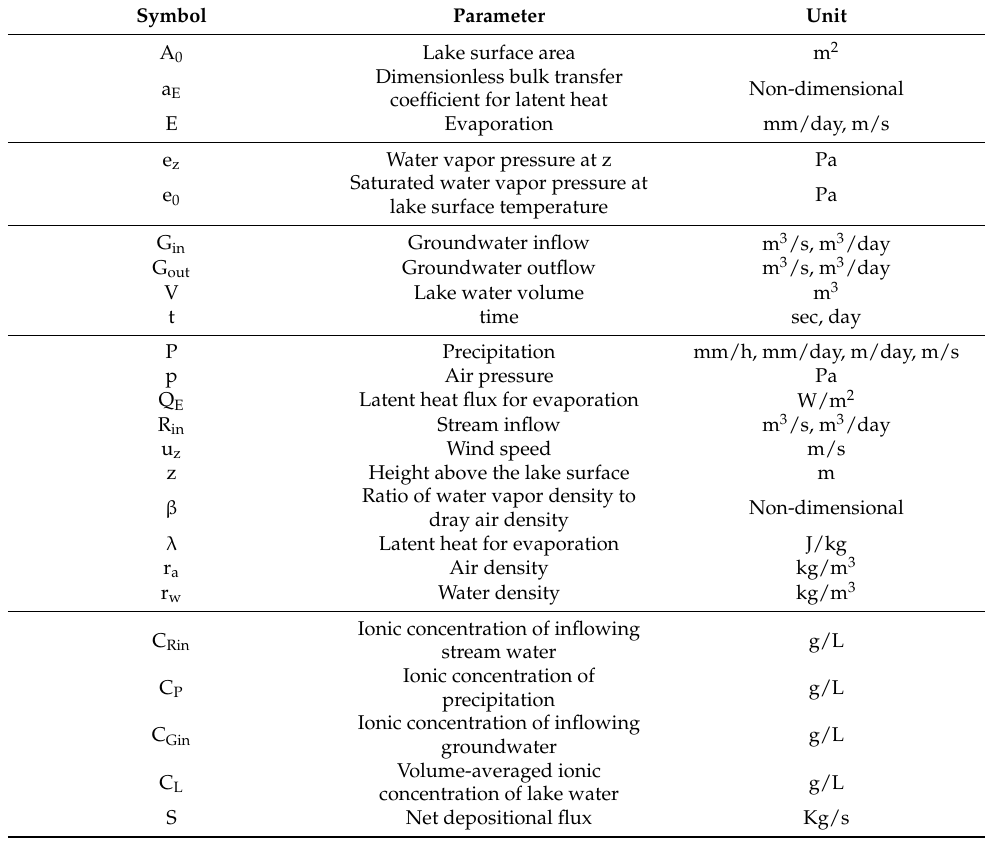
Table A1. Parameters in Equations (1)–(3) and (5).